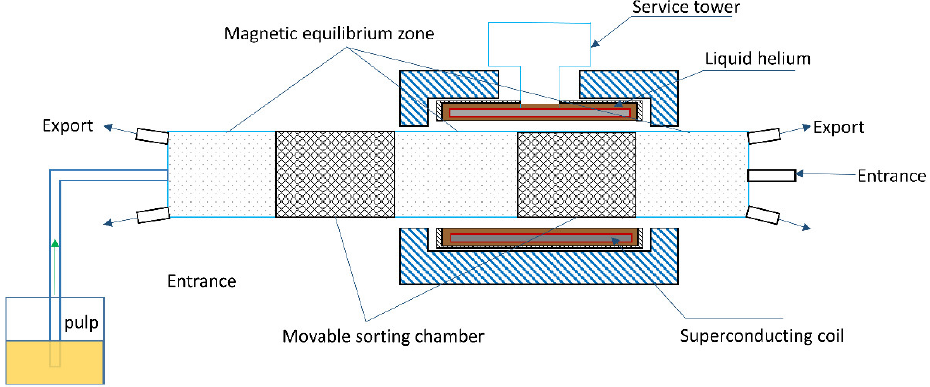
Figure 3. Structure diagram of sorting system.